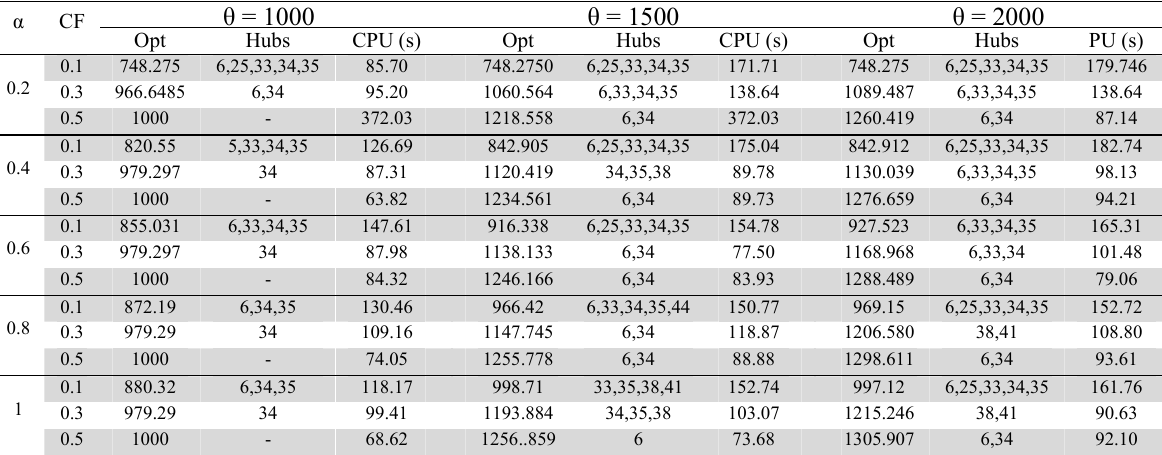
Results for the TR data